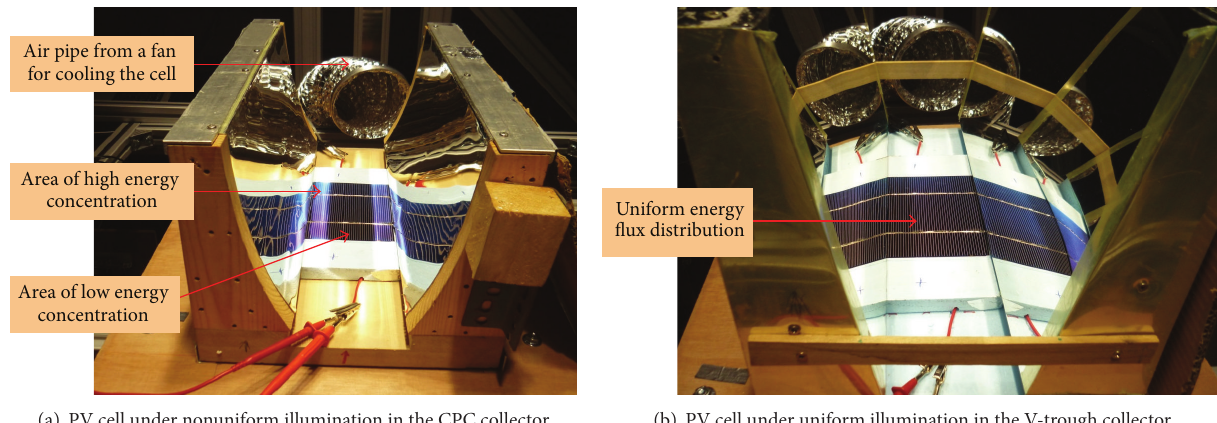
Figure 2: Experimental energy flux distribution on the surface of a PV cell for two different photovoltaic concentrators (a) CPC and (b) V-trough